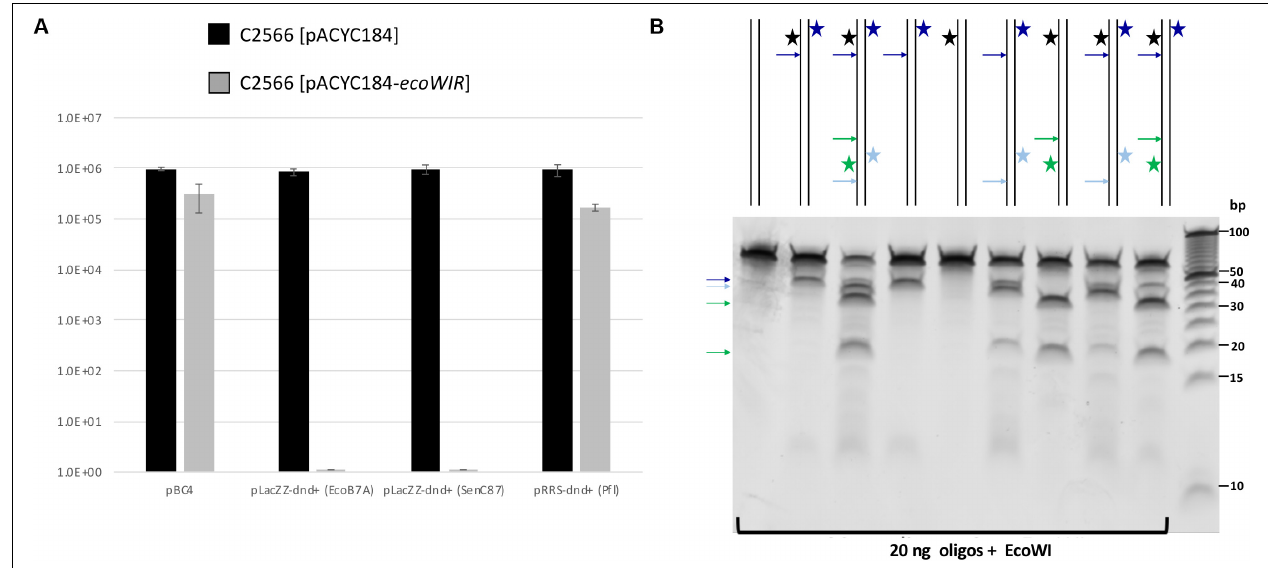
FIGURE 4 | EcoWI in vivo restriction assay and digestion of modified duplex oligos. (A) Transformation efficiency of recipient cells C2566 [pACYC184] and [pACYC184- ecoWIR ] with incoming dnd + plasmids. No transformants were obtained for PT-modified dnd + plasmids (EcoB7A or SenC87) into EcoWI-expressing strain (complete restriction). Control plasmid: pBC4 (pUC19 with adenovirus DNA insert). Control recipient cells: C2566 [pACYC184]. (B) EcoWI digestion of duplex oligos with one or two PT modified sites. 60mer oligoduplexes with PT modification in one or both strands indicated by a star (20 ng, ∼ 26 nM) were digested by EcoWI endonuclease ( ∼ 1.5 µ M) in buffer 2.1 at 37 ◦ C for 30 min. Bold arrows indicate possible cleavage sites near the PT modified sites. 5 bp DNA size marker (10–100 bp, Thermo Fisher